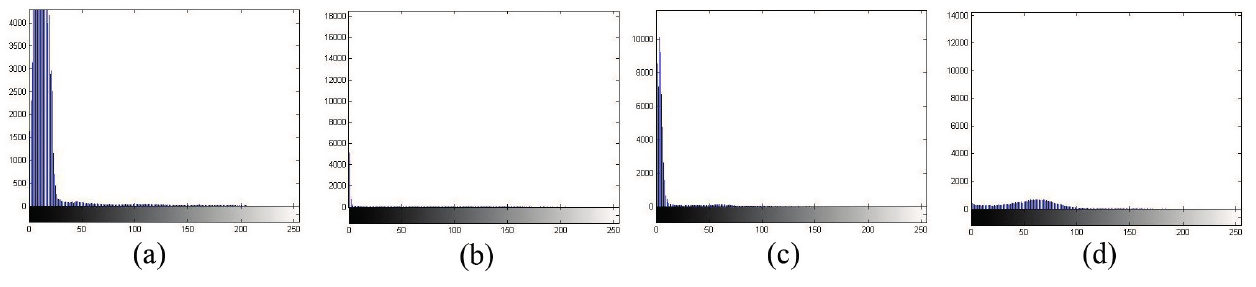
Figure 7. Histogram of the C component of four images in Figure